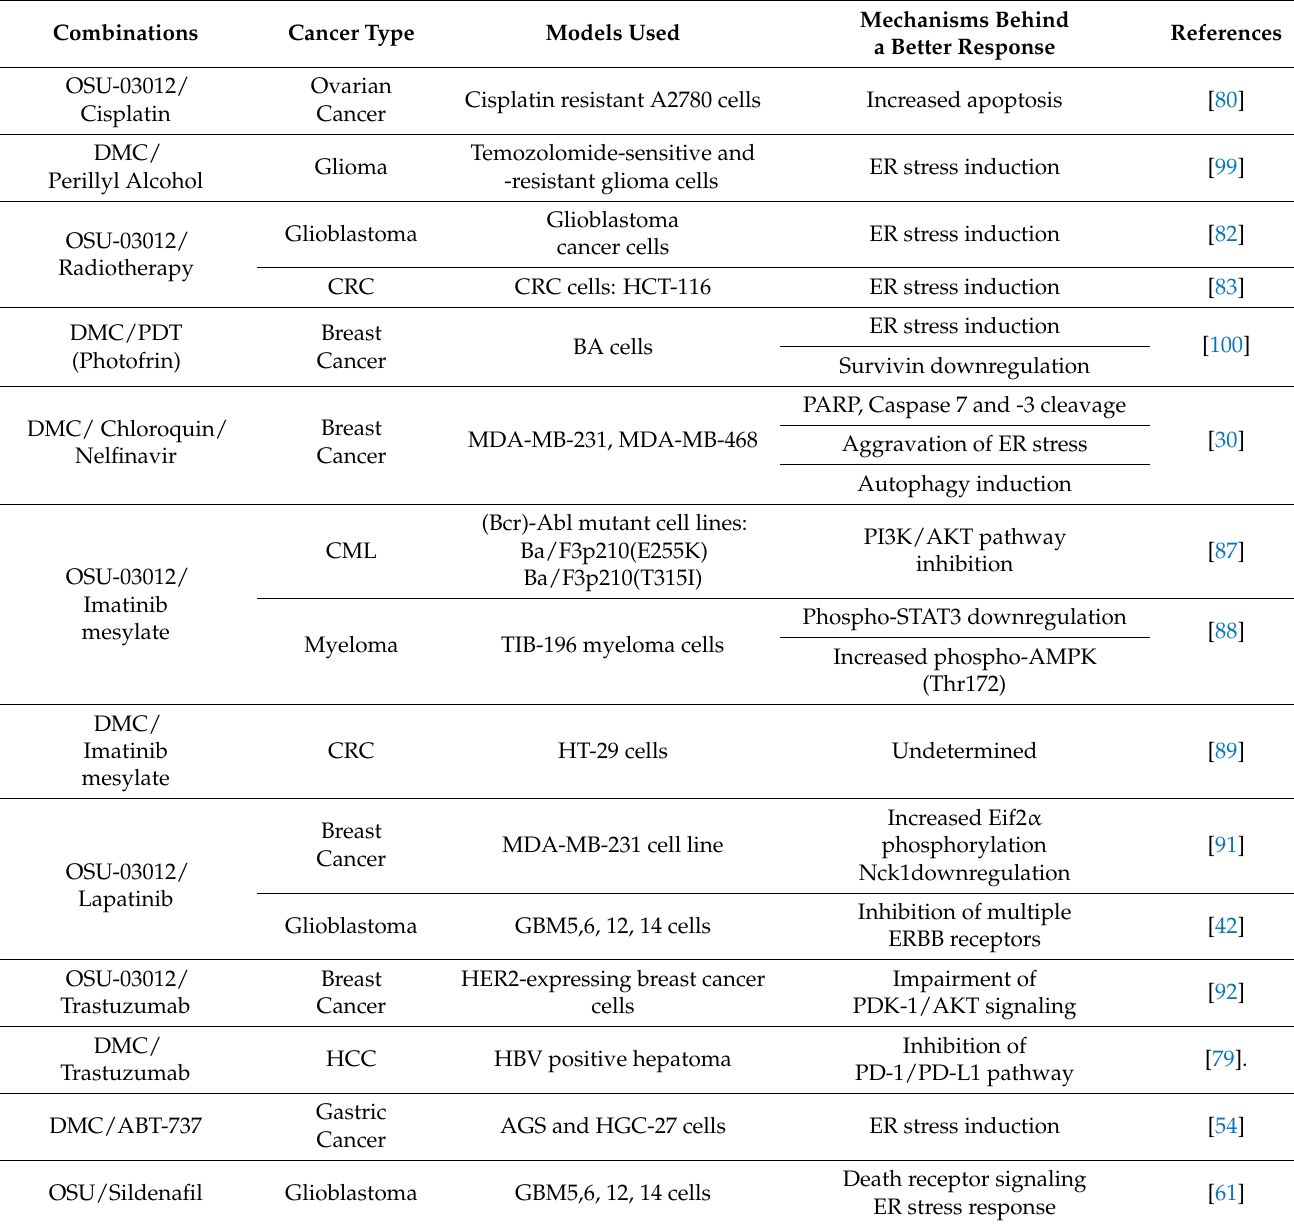
Table 2. Combinations between OSU or DMC with other anti-cancerous